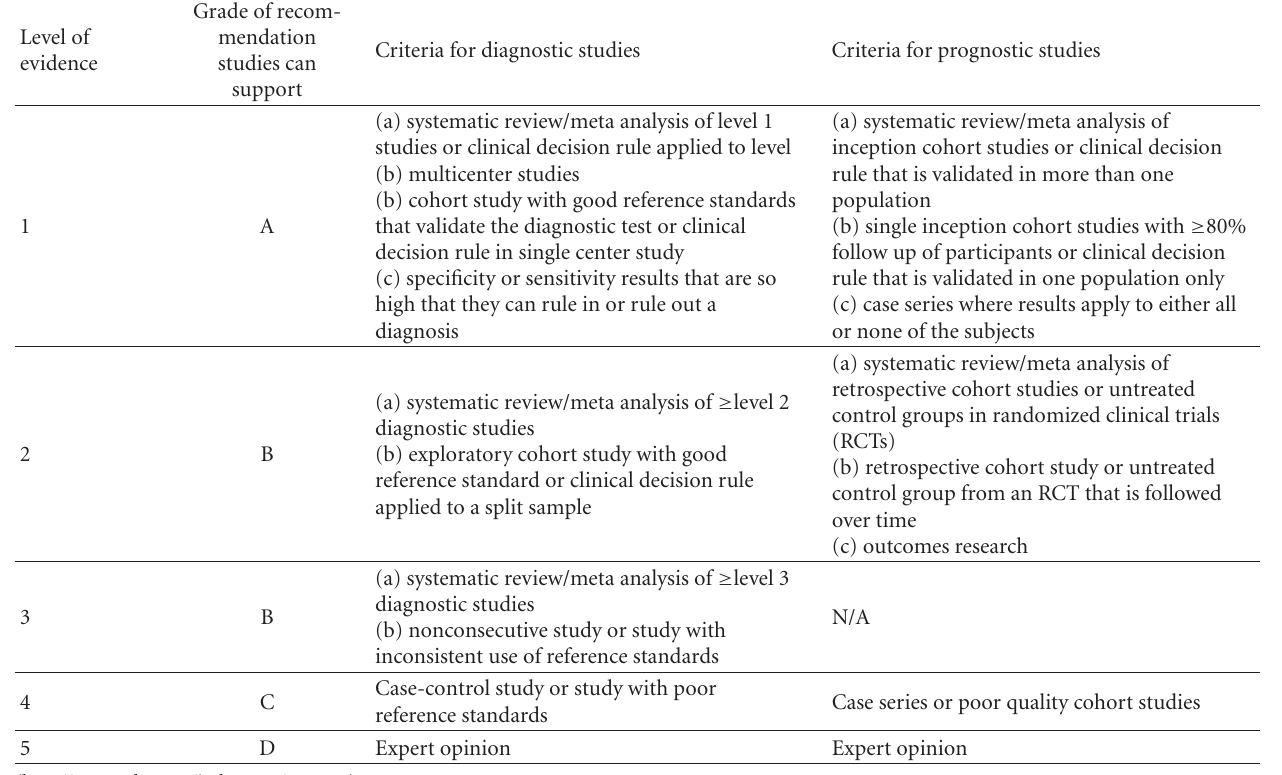
Table 1: Oxford Centre for Evidence-based Medicine definitions of levels of evidence. The following table summarizes the criteria that must be satisfied for the five di ff erent levels of evidence for both diagnostic and prognostic studies as well as the grading of recommendations assessment, development, and evaluation (GRADE) that studies with a given level of evidence will